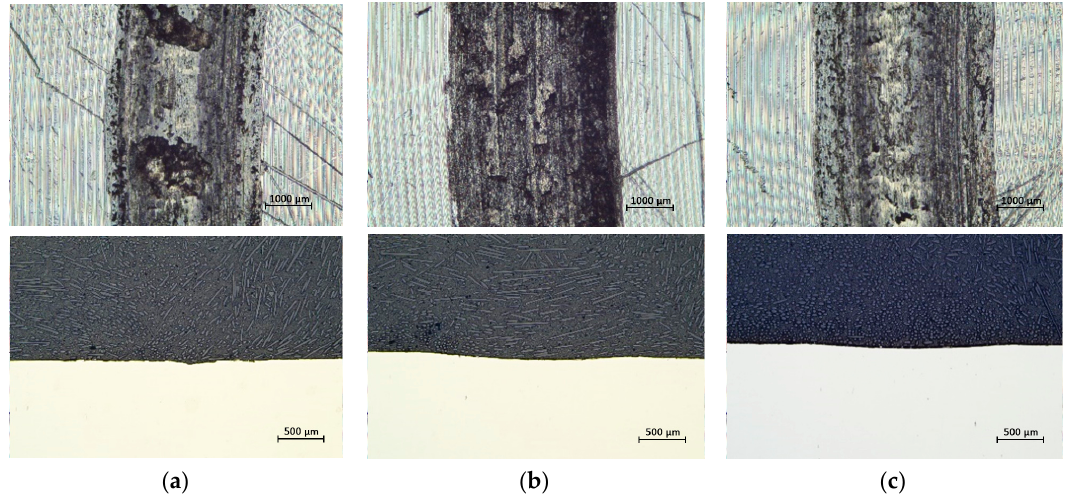
Figure 8. Worn surfaces and cross section of the traces of tribological pair at friction speed (m/s): ( a ) 0.8, ( b ) 1.0, ( c ) 1.2